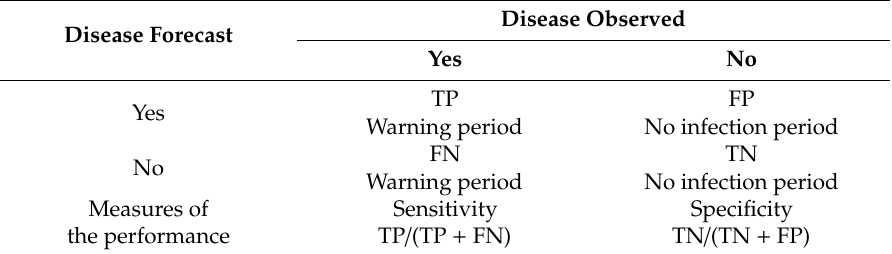
Table 3. Confusion matrix used for calculating the cutoff points for contingency tables.